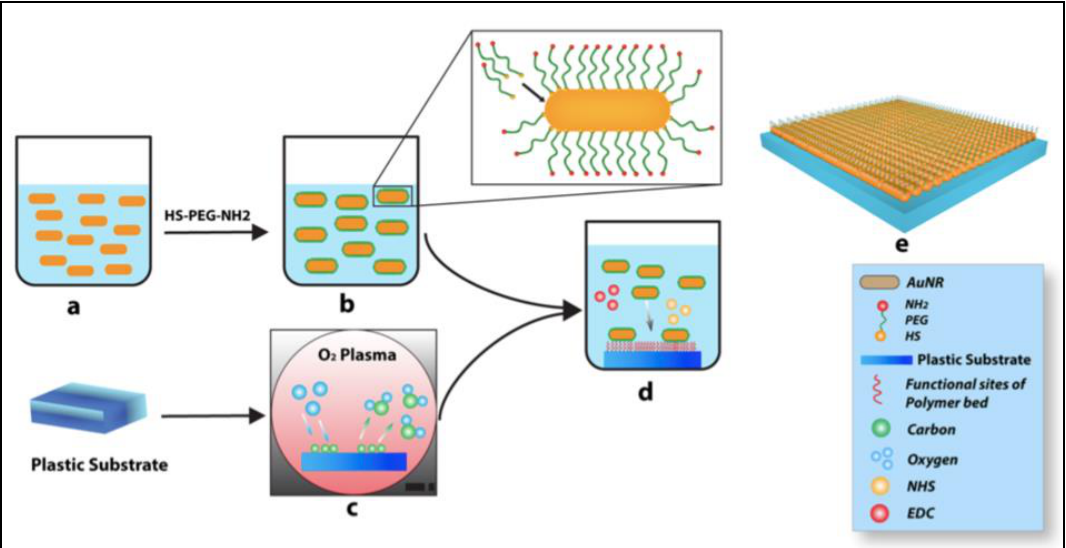
Figure 9. Protocol used to fabricate PNF two-dimensional (2D) system. ( a ) AuNRs preparation ( b ) Functionalization of AuNRs, ( c ) O 2 plasma treatment to the plastic substrate, ( d ) Coating the plastic substrate with functionalized AuNRs ( e ) Washing with Di water, and then treatment with ethanol and UV for sterilization. Reproduced with permission from [9]. Springer Nature,